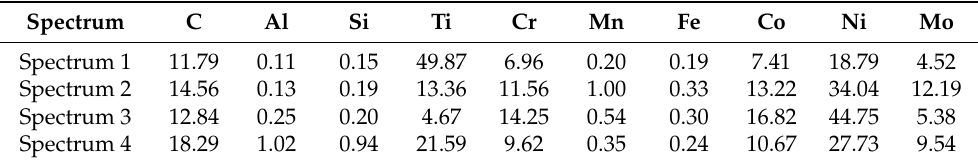
Table 4. EDS analysis of the spots denoted in Figure 5.